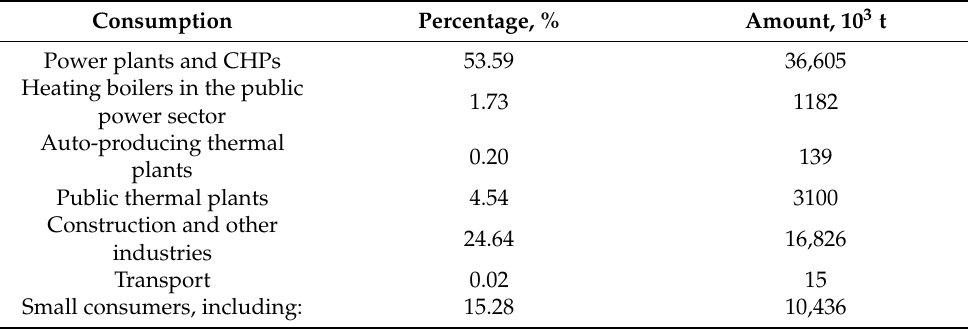
Table 1. Hard coal consumption in Poland in 2019 according to